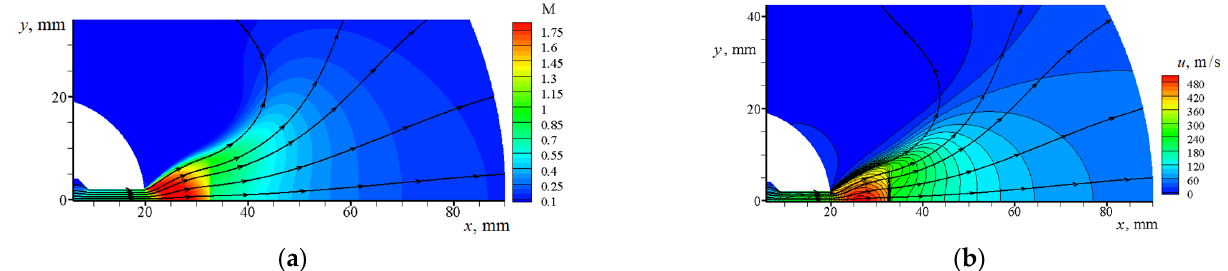
Figure 14. Calculated data for a gas jet without particles exhausting from a channel into a slot space with 0.2 mm h  : ( a )—Mach ‐ number isolines M( , ) x y and gas ‐ flow streamlines; ( b )—longitudi ‐ nal gas velocity ( , ) u x y and gas ‐ flow streamlines.